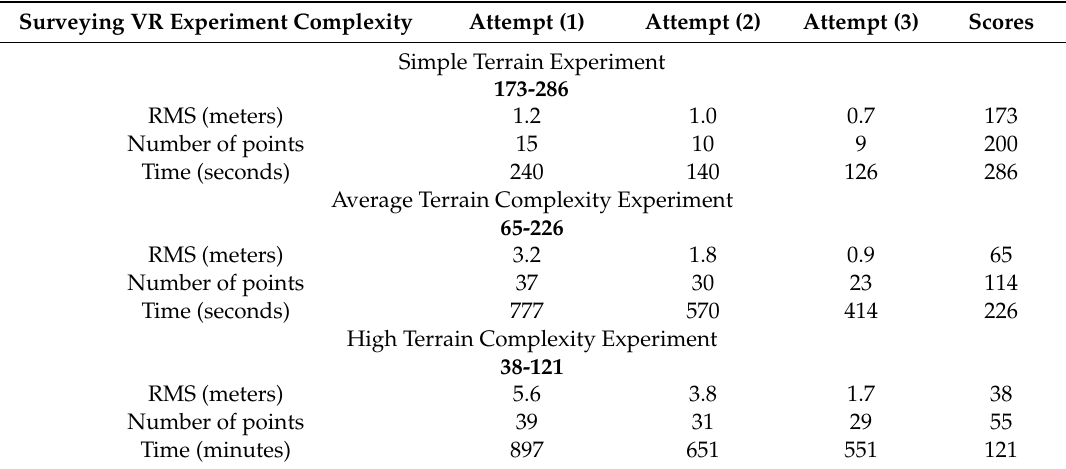
Table 4. Surveying VR gamification experimental results.